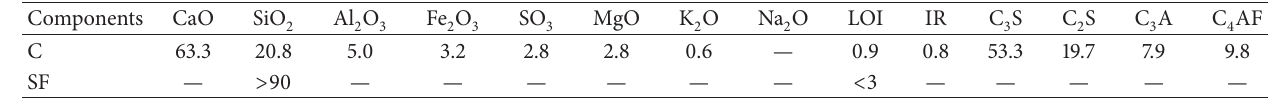
Table 1: Chemical composition of cement and SF.